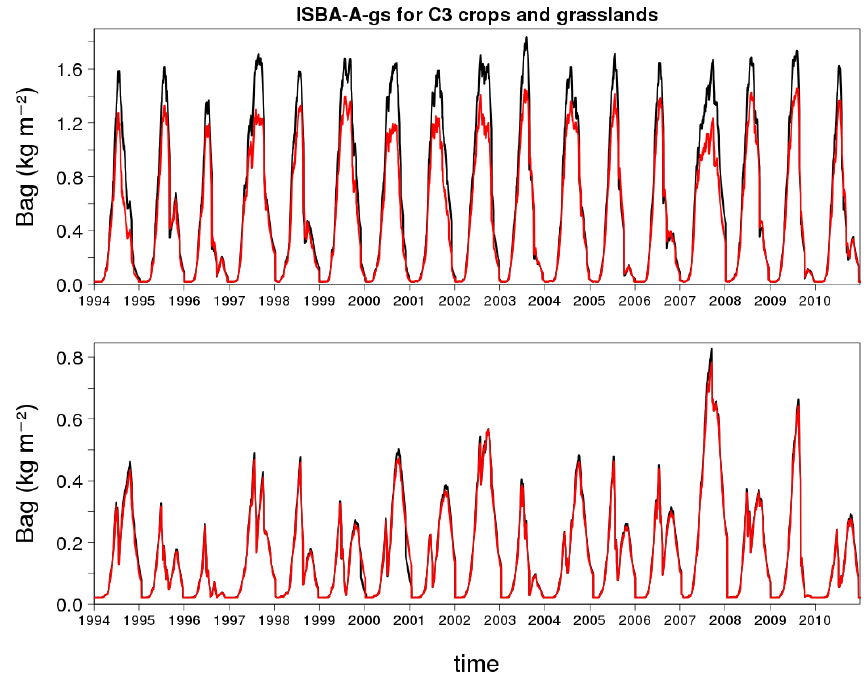
Figure 13. Simulations over the 1994–2010 period in the 61-Orne département of the above-ground biomass for (top panel) C3 crops ( g m = 1.75mms − 1 , MaxAWC = 225mm) and (bottom panel) grasslands ( g m = 0.50mms − 1 , MaxAWC = 50mm) for the DIF1 and DIF1- NRT configurations (black and red lines,